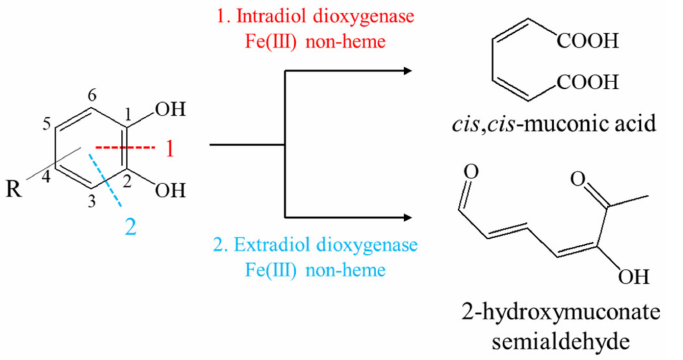
Figure 1. Structure of catechol where the C1–C2 bond cleavage site is marked red, and the decay of C2–C3 is marked